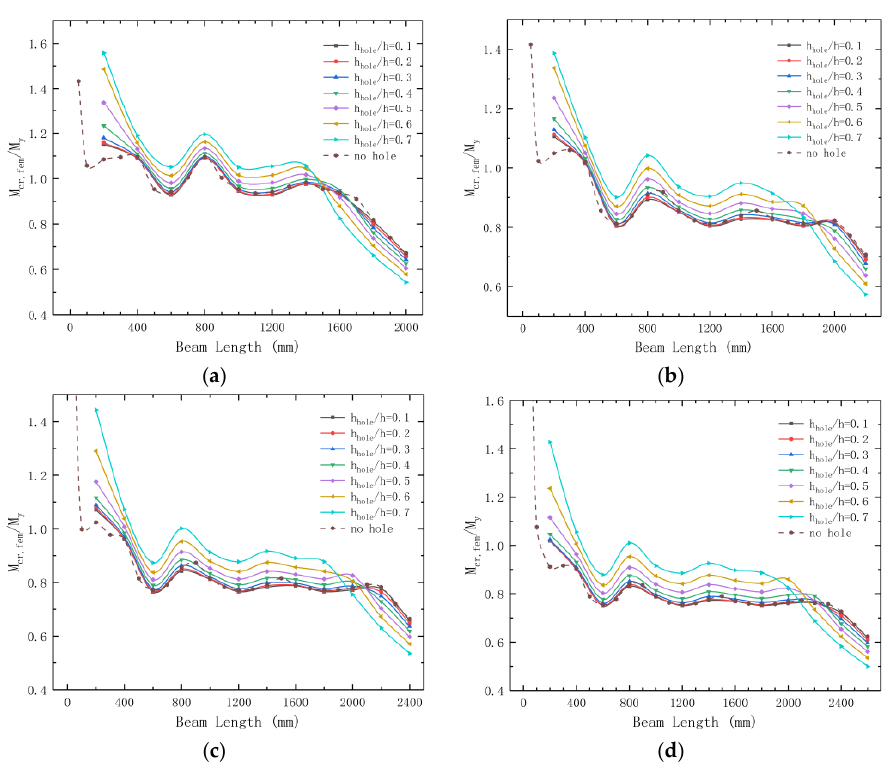
Figure 8. Distortional buckling curves of CFS channel-section beams with edge-stiffened holes ( 𝜎 𝑦 = 600 𝑀𝑃𝑎; 𝑀 𝑦 is the yield moment of CFS beams; 𝑙 ℎ𝑜𝑙𝑒 𝑙⁄ = 0.5 ). ( a ) Section A (h = 180, b = 60, c = 20, t = 2.0, and e = 9). ( b ) Section B (h = 200, b = 70, c = 20, t = 2.2, and e = 9). ( c ) Section C (h = 240, b = 75, c = 20, t = 2.5, and e = 9). ( d ) Section D (h = 300, b = 80, c = 20, t = 3.0, and e = 9).